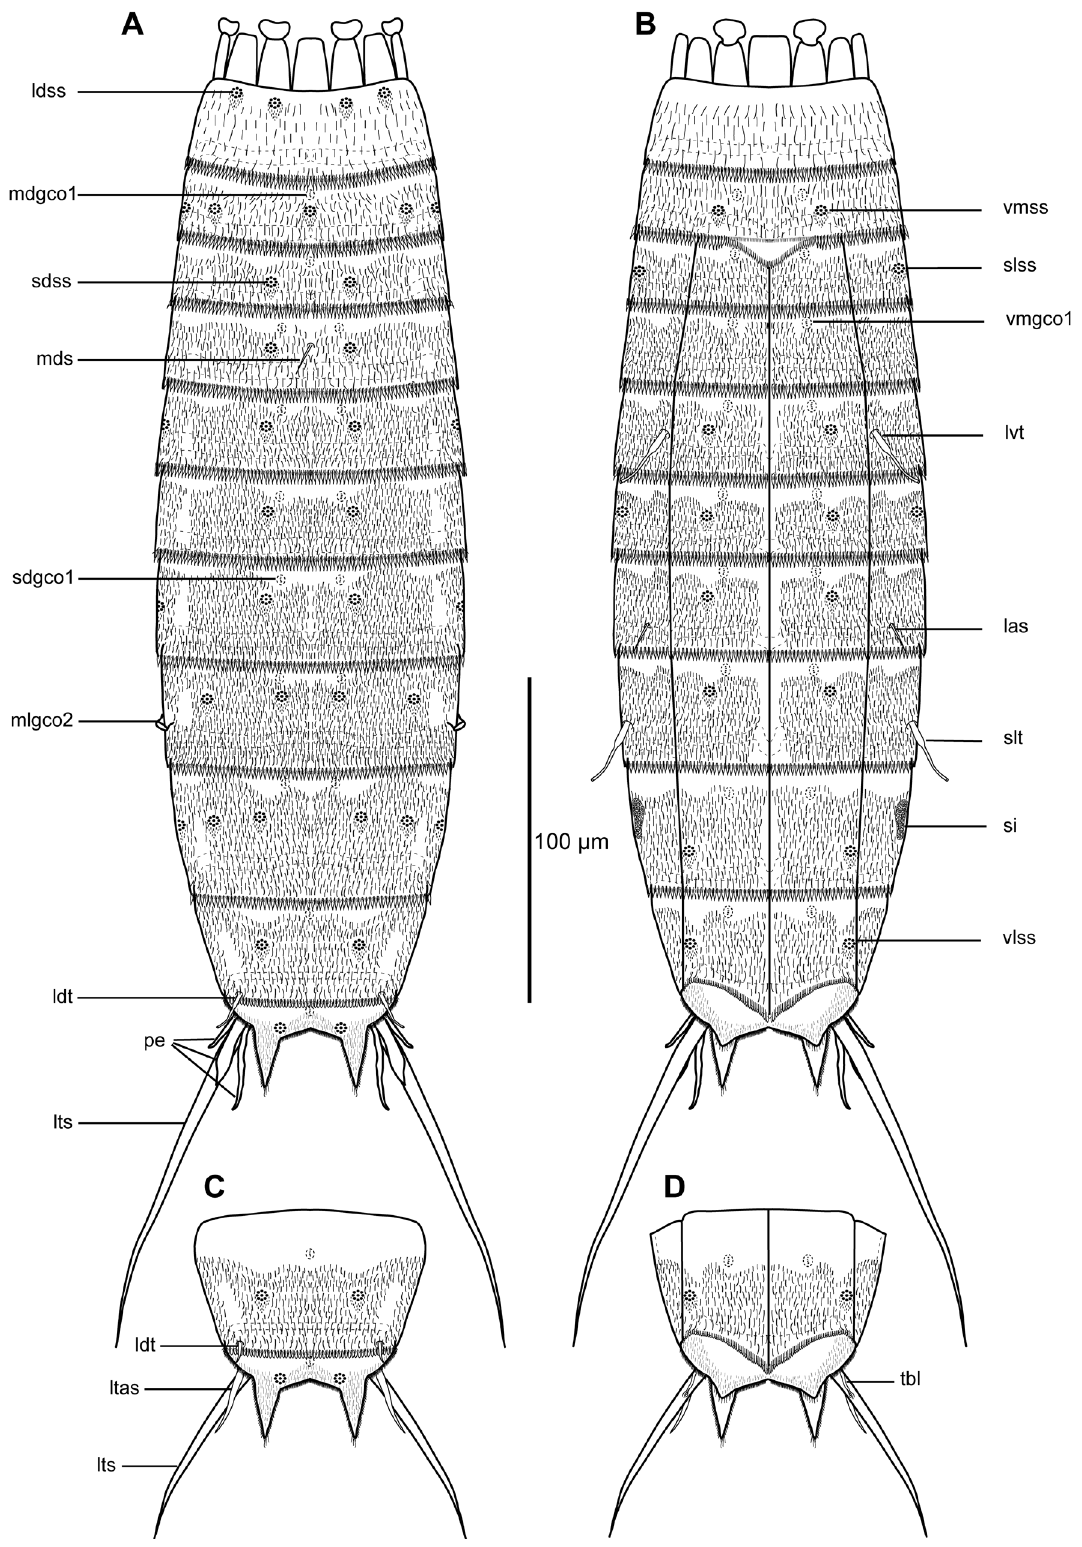
Fig. 2. Line art illustrations of Echinoderes blazeji sp. nov. A . ♂, dorsal view. B . ♂, ventral view. C . ♀, segments 10–11, dorsal view. D . ♀, segments 10–11, ventral view. Abbreviations: see Material and